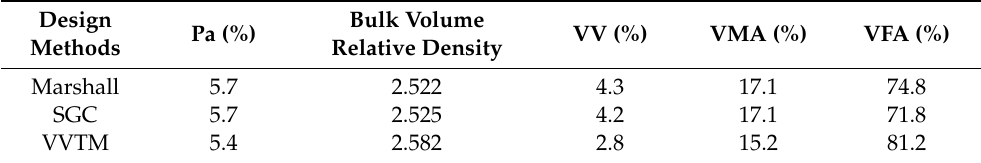
Table 11. Comparison of the physical properties of the stone mastic asphalt (SMA)-13 asphalt mixture.